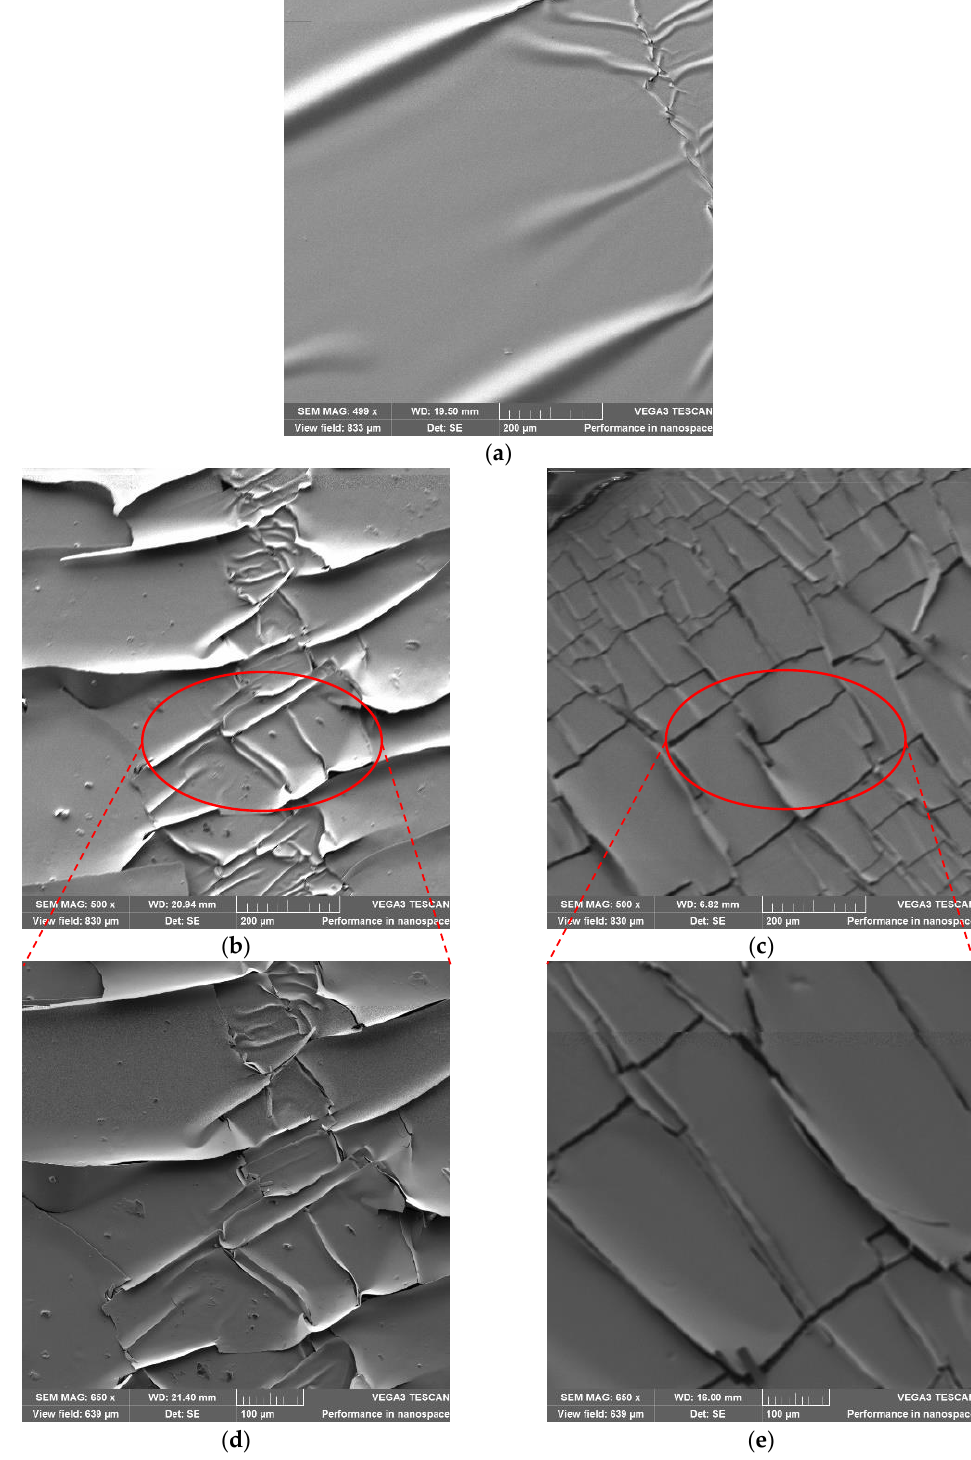
Figure 7. SEM images of straight line patterns at different pre-stretching strains: ( a ) 0%; ( b ) 27% axial pre-stretching with a scale of 200 µm; ( c ) 27% radial pre-stretching with a scale of 200 µm; ( d ) 27% axial pre-stretching with a scale of 100 µm; and ( e ) 27% radial pre-stretching with a scale of 100 µm.